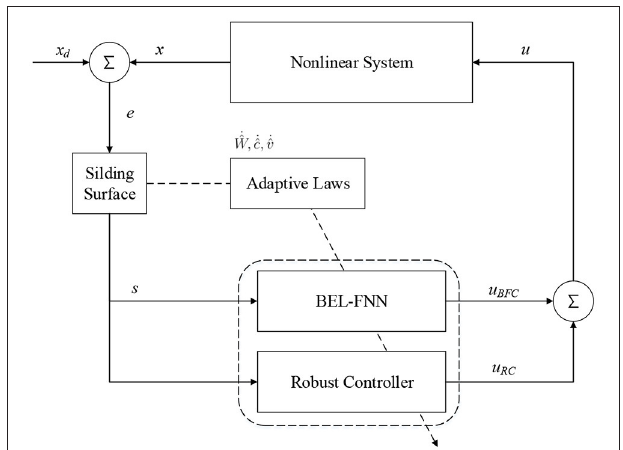
FIGURE 3 | Design of control system.